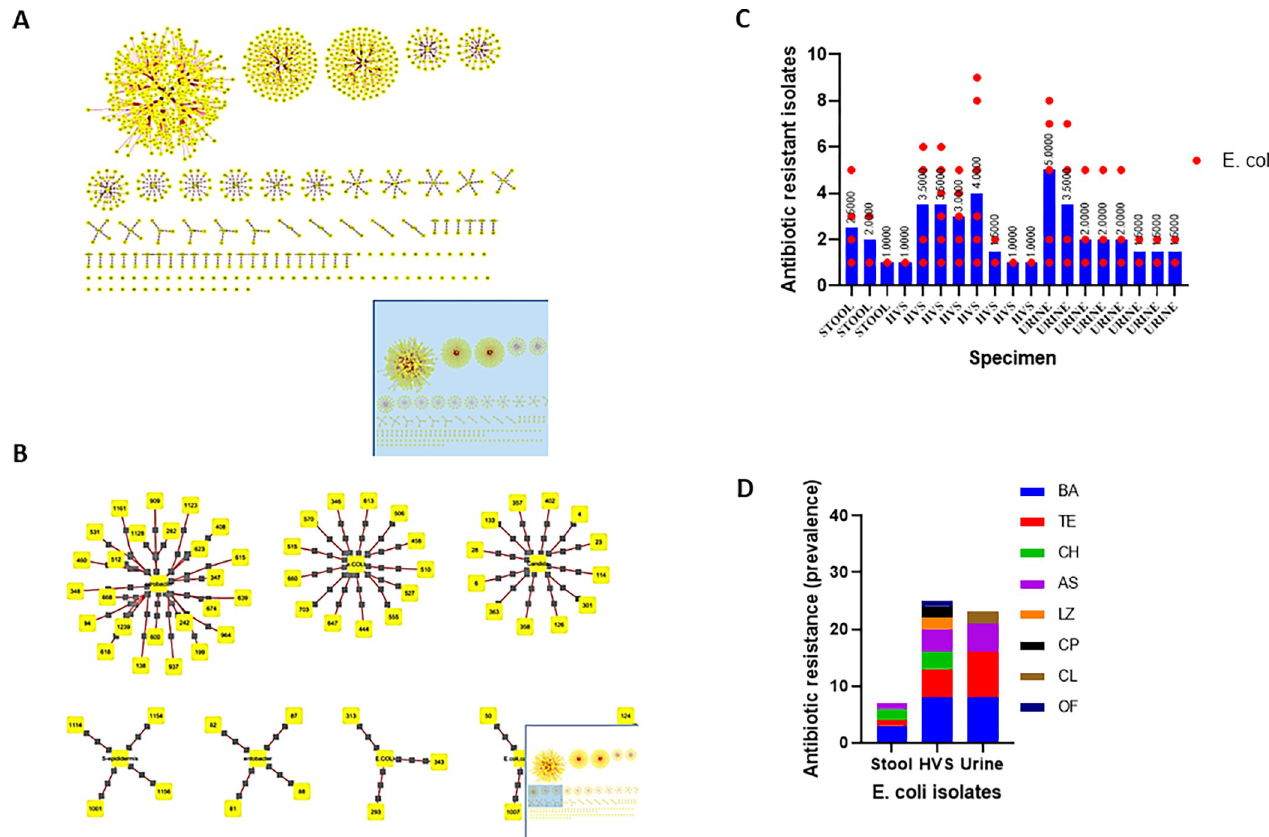
Fig 3. A unique and separate interactions of bacteria isolates and antibiotic resistance pattern. A. Bacteria isolates interaction network, in which nodes represent different associations with antibiotic resistance and bacteria isolates. B. Zoom-in of the interaction networks showing individual bacteria isolates forms a separate and unique interaction. The Escherichia coli and Citrobacter species showed interesting interaction networks. C. The different antibiotic resistance patterns of Escherichia coli isolates from the stool, High vaginal swabs (HVS) and urine specimens. The bar graph is the mean E . coli isolates with similar antibiotic resistance pattern and each dot represents the mean of the individual antibiotics. D. The stacked bars show the various antibiotics and the prevalence of resistant Escherichia coli isolates from stool, HVS and urine. Bactrim (BA), tetracycline (TE), ampicillin-sulbactam (AS), clindamycin (CL), ofloxacin (OF), lincomycin (LZ) and chloramphenicol